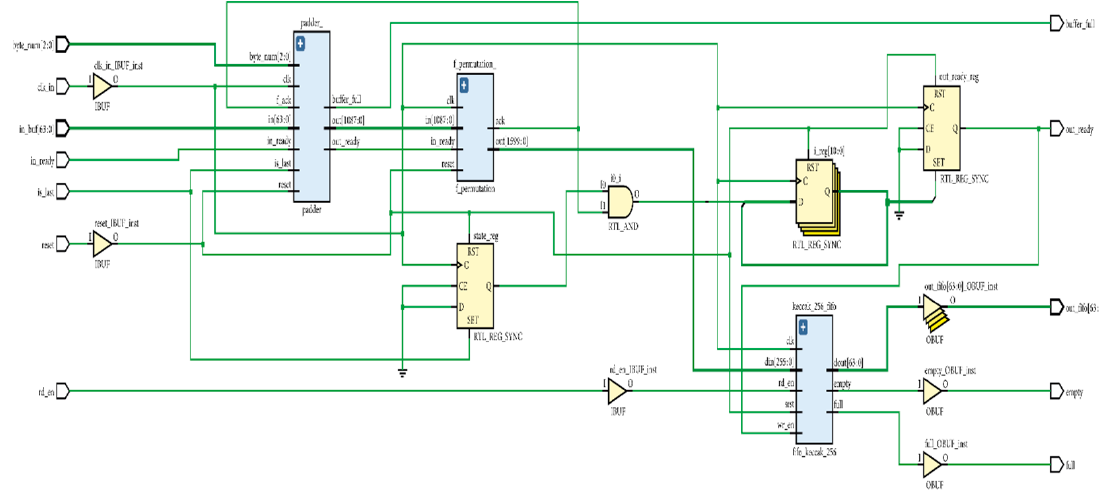
Figure 6. Internal architecture of one Keccak hardware accelerator (IP).